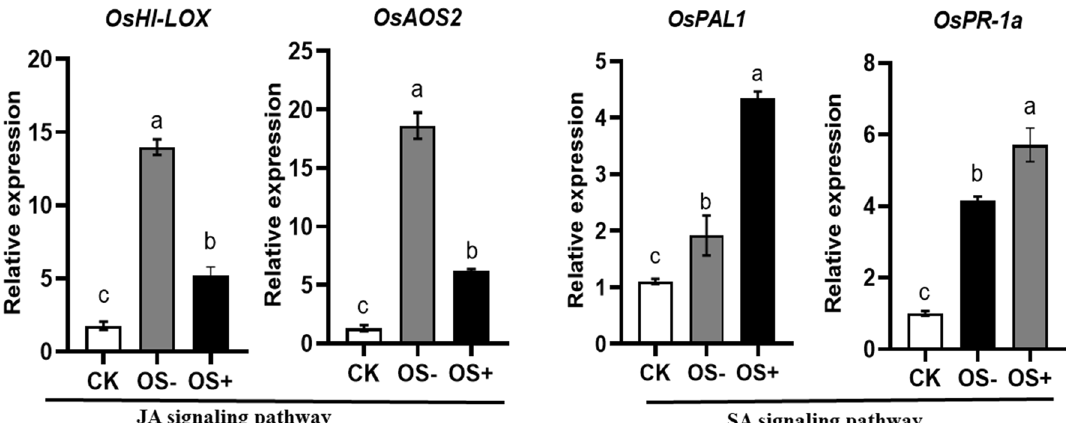
Fig. 8 Expression levels of JA and SA signaling pathway-related genes in rice plants treated with wounding and OS collected from larvae inoculated with Enterobacter . Gene expression was analyzed 24 h after treatment. Different letters indicate statistically significant differences 166.7, P < 0.001; OsAOS2 , F (2,15) 181, P < 0.001; OsPAL1 , F (2,15) 60.68, between treatments (ANOVA, P < 0.05; followed by LSD test; OsHI-LOX , F (2,15) = = = P < 0.001; OsPR-1a , F (2,15) 73.35, P < 0.001; n 6). CK, Untreated rice plants; OS , OS collected from larvae inoculated with Enterobacter ; OS-, OS = = + collected from larvae inoculated with only MgCl 2